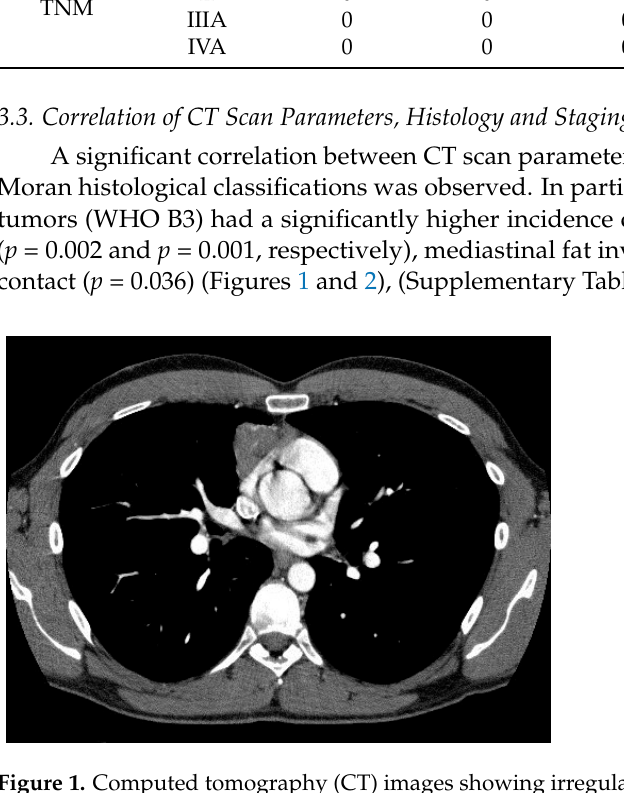
Figure 1. Computed tomography (CT) images showing irregular shape and contours. A higher incidence of regular contours ( p = 0.034) and a lower incidence of lung ( p = 0.009) invasion were observed in patients with stage I tumors according to the TNM stag- ing system (Figure 3). Stage I tumors according to M-K had a higher incidence of oval shape ( p = 0.003) and a lower incidence of mediastinal fat invasion ( p = 0.022), contact with mediastinal vessels ( p = 0.008) and pericardium ( p = 0.032) (Table 4).